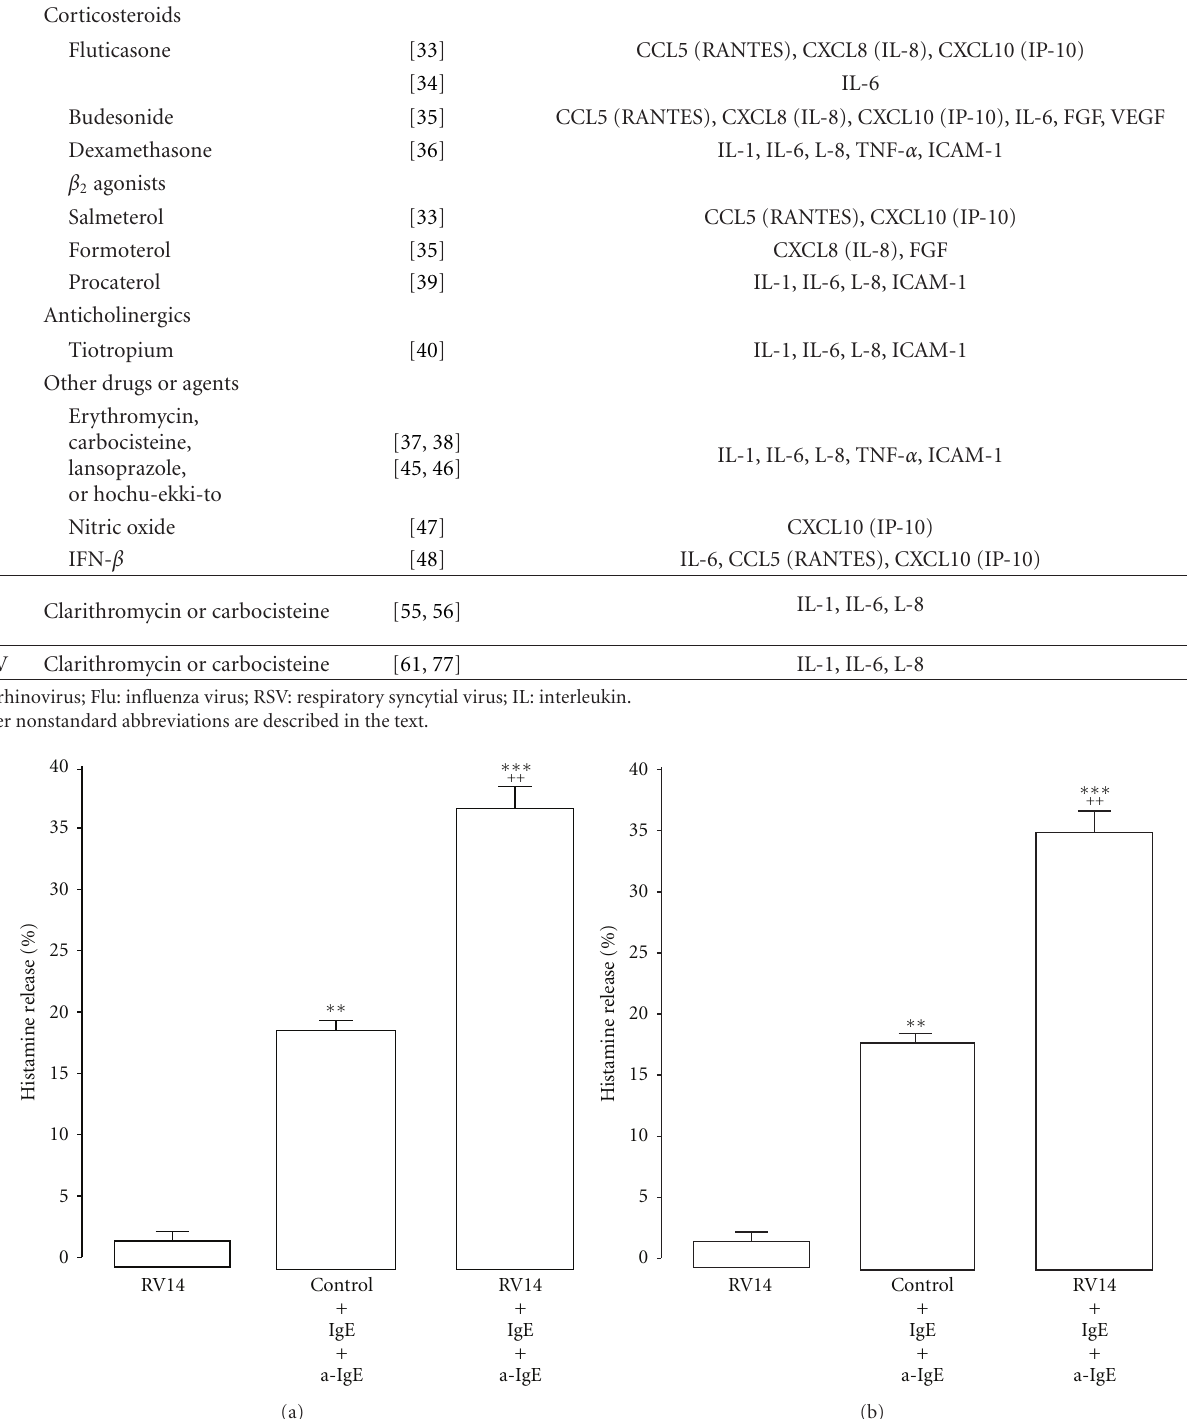
Table 2: Inhibitory e ff ects of drugs or agents on the production of cytokines, mediators, and substances induced by virus infection. Viruses Sample(s) and specimen(s)